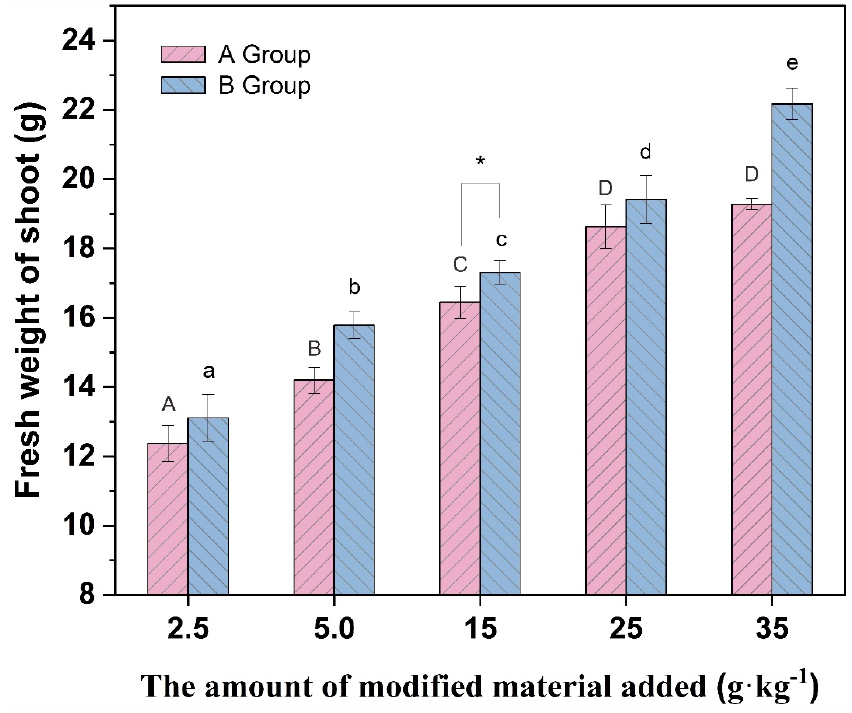
Figure 6. Fresh weight of stems and leaves of different groups of vegetables. (* indicates values significant at p < 0.05). Different letters above the bar diagram indicate the significant difference of fresh weight of shoot in different groups of soil.